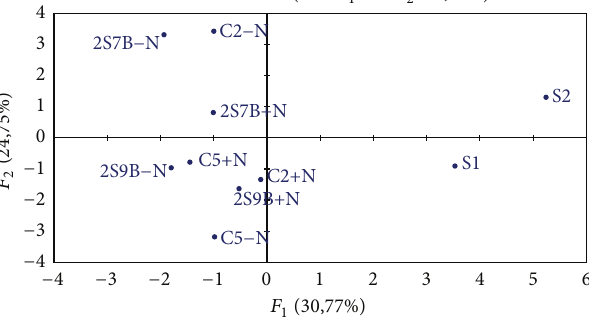
Figure 2: PCA: projection of the cases on the factor